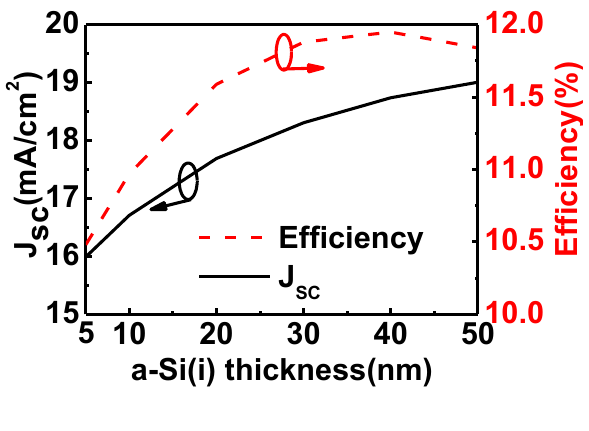
Figure 6. Short-circuit current density and efficiency of HIT solar cells as a function of the thickness of the top a-Si:H(i) layer when the bulk c-Si was 1.5 µm